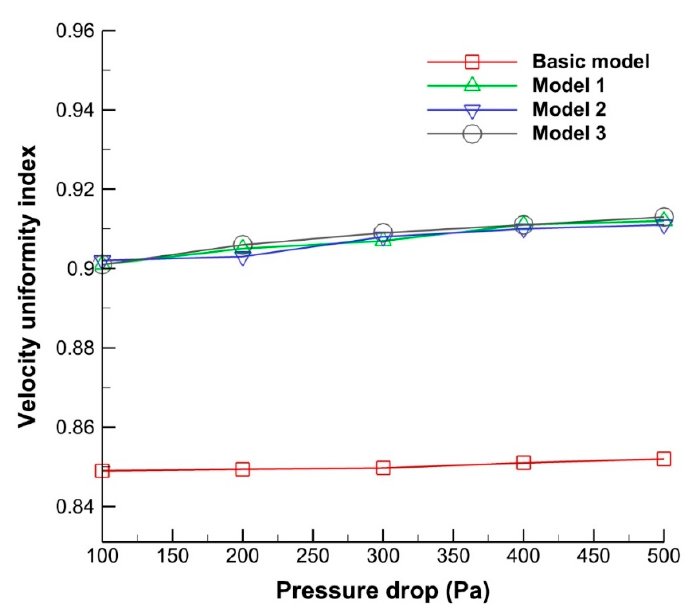
Figure 10. Comparison of velocity uniformity index at the outlet between the basic torch and the three new gas torches as a function of pressure drop.